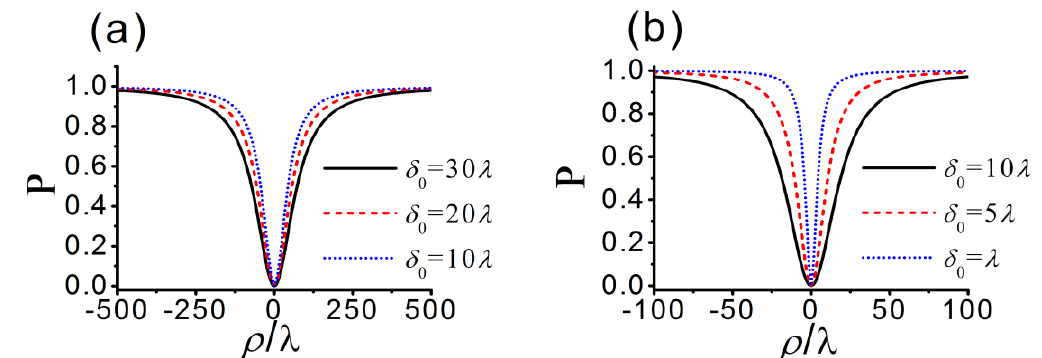
10  z z with R 10  z z with R  . 0  . 0